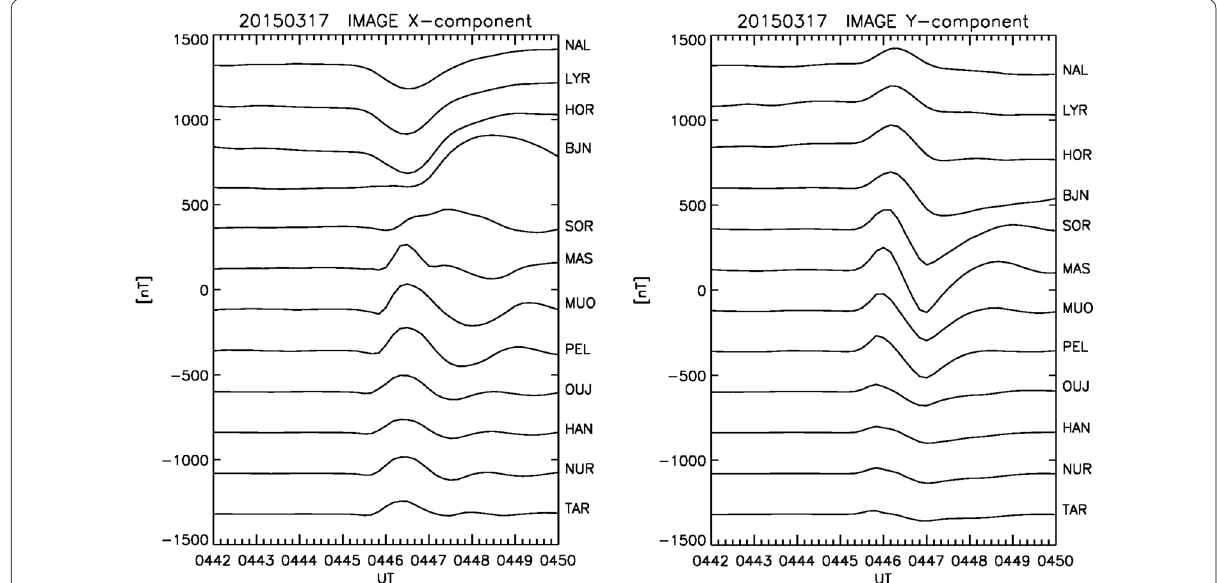
Fig. 6 SCs recorded in the X- and Y-components of the magnetic field at the IMAGE magnetometer array stations deployed in the morning sector (07 MLT) from the polar cap, Ny Alesund (NAL, 75.25º CGML) to middle latitude, Tartu (TAR, 54.47º CGML). The PI in X is positive at lower latitudes, while negative at higher latitudes from Bear Island (BJN, 71.45º CGML). In contrast, the PI in Y is positive at all stations. The latitudinal features of the X and Y meet the dawnside part of the counter-clockwise Hall current vortex surrounding the upward